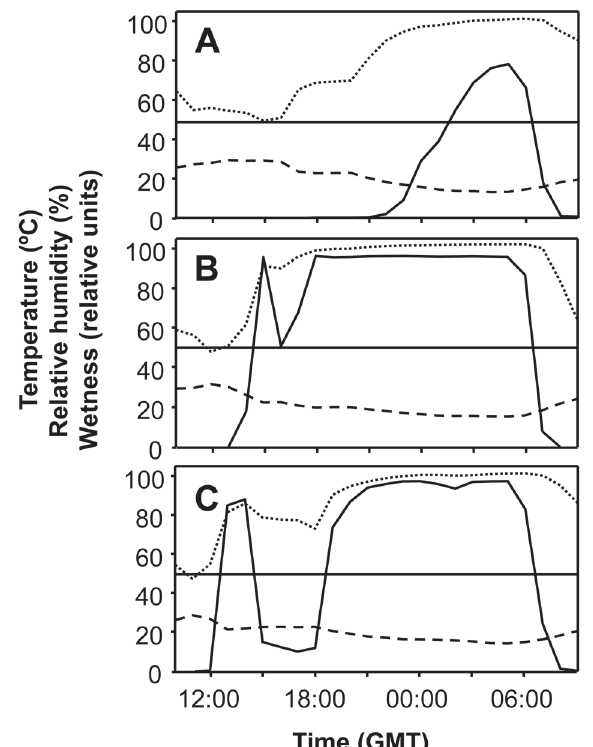
Figure 3. Patterns of the dynamics of wetness (solid line), temperature (dashed line), and relative humidity (dotted line) in the pear orchards studied. A, wetness caused by dew; B, interrupted wetness period with high relative humid- ity (≥90%); C, interrupted wetness period with low relative humidity